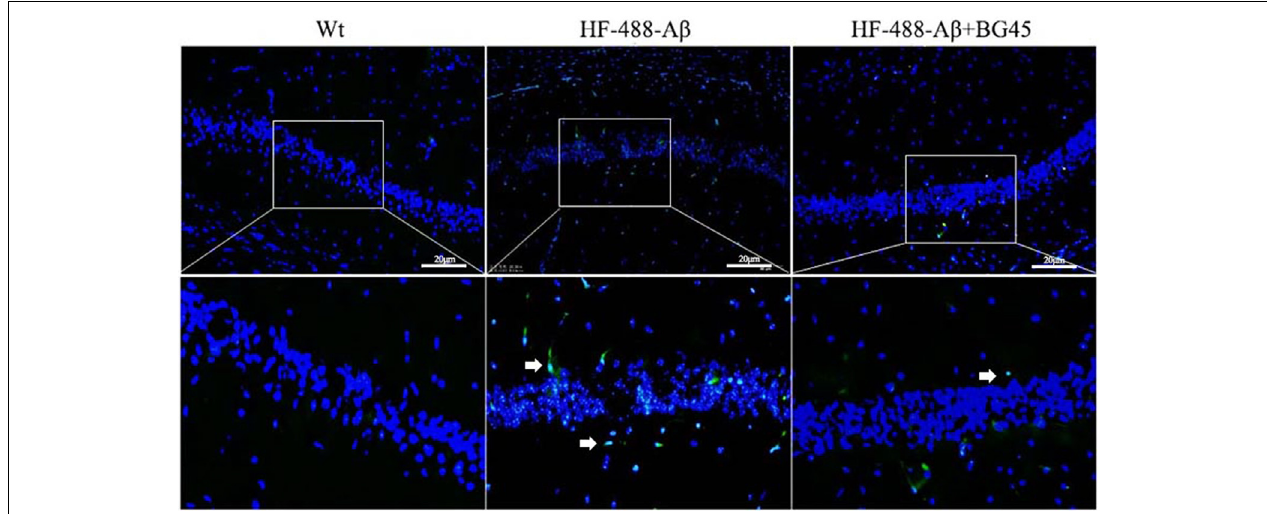
FIGURE 5 | The fluorescence in the hippocampus after HF-488-A β 1–40 intravenous injection. Merged image shows an overlay of HF-488-A β 1–40 (green) and DAPI staining of the nucleus (blue) in the HF-488-A β and HF-488-A β + BG45 group. Arrows indicate the HF-488-A β 1–40 in the hippocampus. n = 5. Scale bar corresponds to 50 µ m.